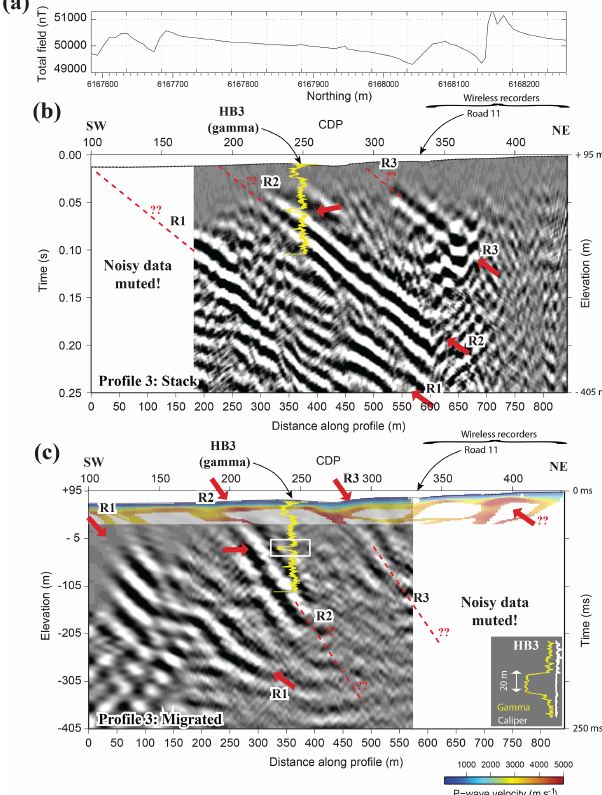
Figure 10. (a) Ground total-field magnetic, (b) unmigrated and (c) migrated (also time-to-depth-converted) reflection seismic sec- tions along profile 2. The tomographic velocity model is projected onto the migrated section for direct comparison. Red arrows mark the main reflections. They may extend at depth but we are unable to image them due to the short length of the profile. Downhole logging results from boreholes HB2 and HB5 suggest that the reflections R2 and R3 are associated with the zone of reduced natural gamma, high density and low resistivity. The caliper log suggests no change in the borehole diameter. Based on these, we argue that the reflections originated from dolerite dykes.